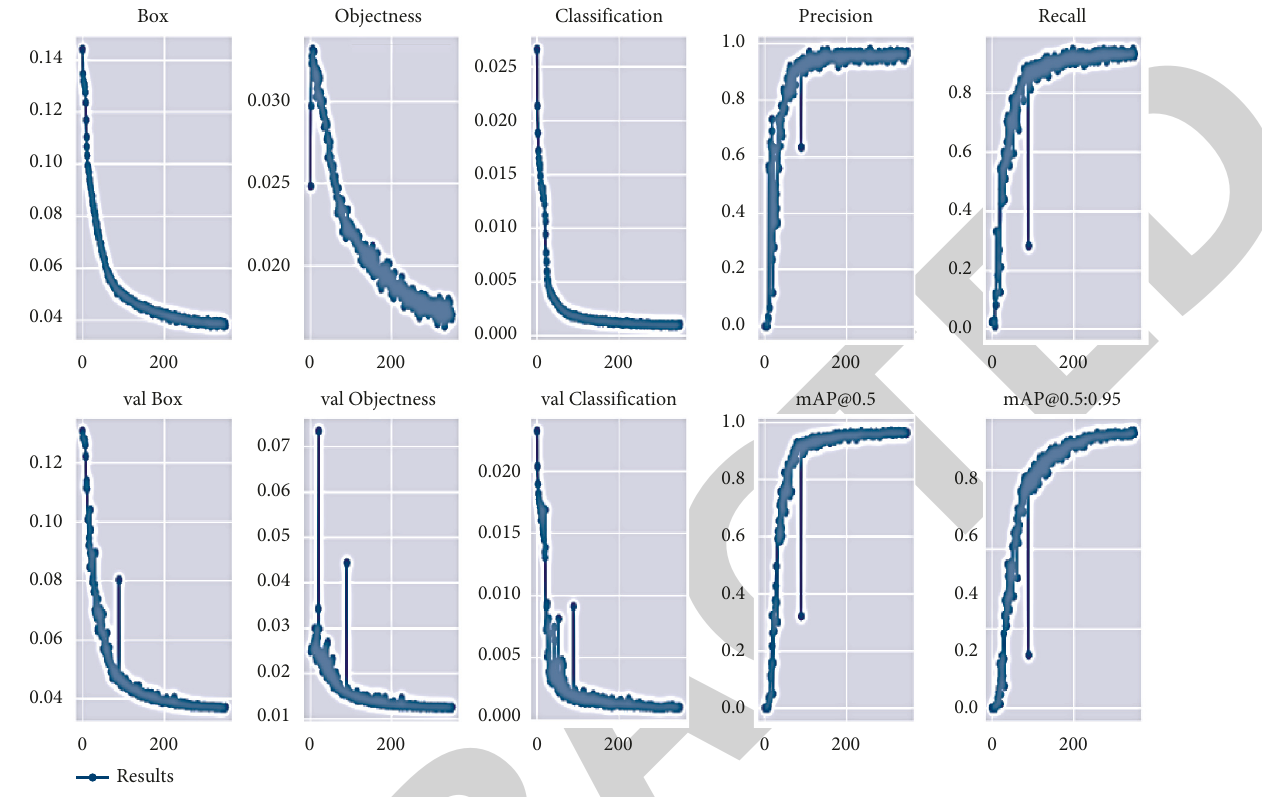
Figure 10: Plots of box loss, objectness loss, classification loss, precision, recall, and mean average precision (mAP) for daytime dataset (A) for training and validation.